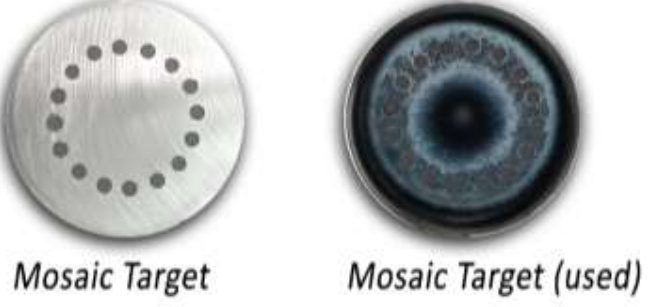
Figure 7: Mosaic targets used in experiments show the erosion of the surface after several hours of